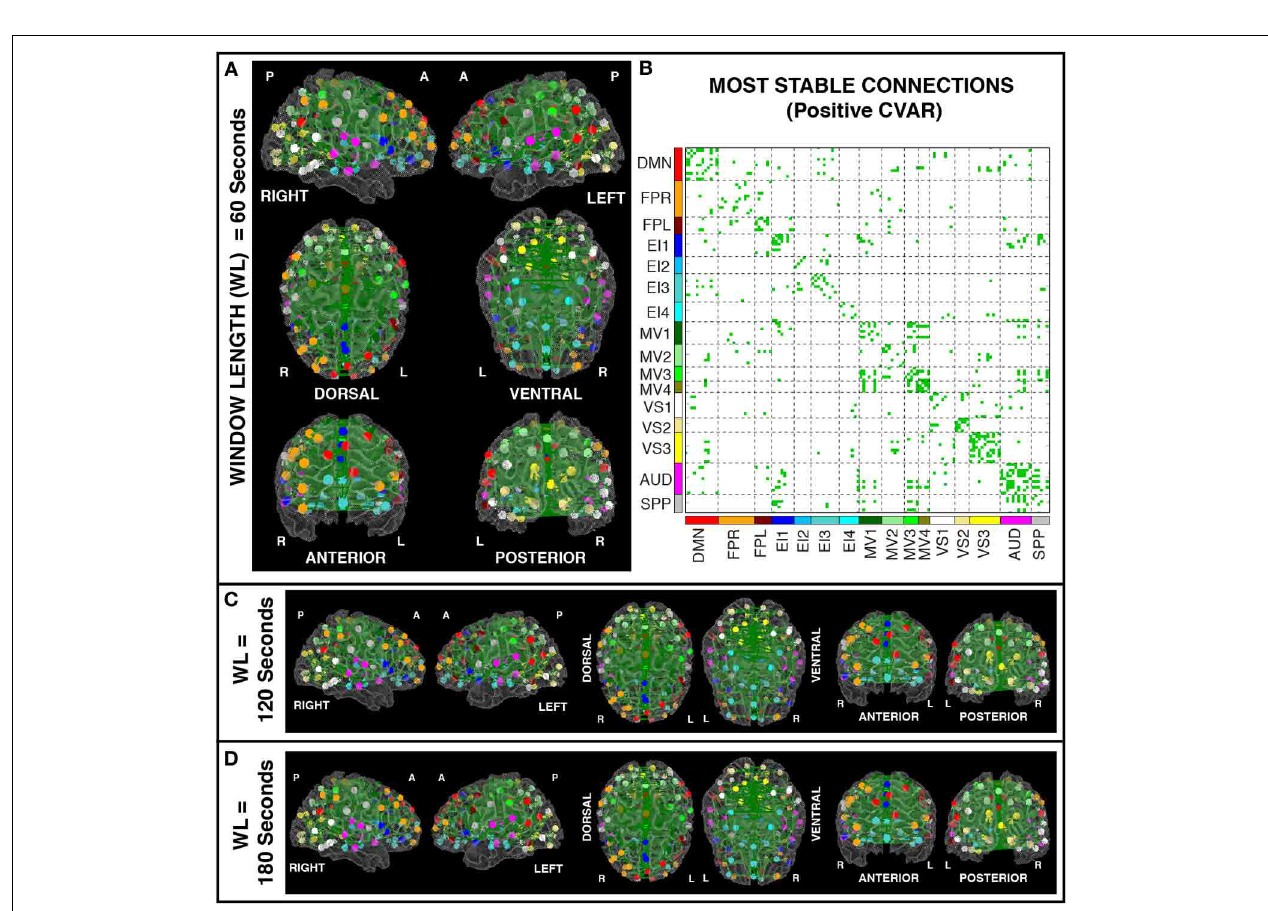
FIGURE 7 | Number of subjects for which a given connection was classified as most variable (A), most stable (B), and with negative CVAR (C). Connections that were consistently classified in the same group for all 11 subjects are marked with a black outline. These are the same connections